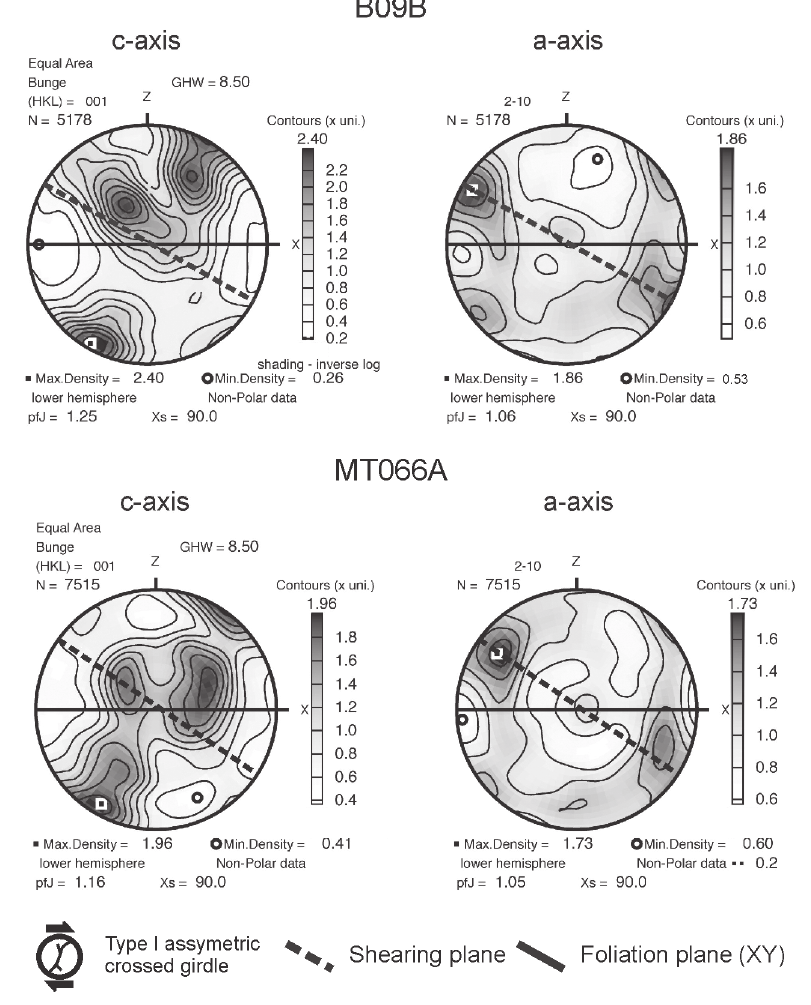
Figure 7 - Isoareal pole figures for the crystallographic axis orientation (LPO) of quartz grains for samples of the Central